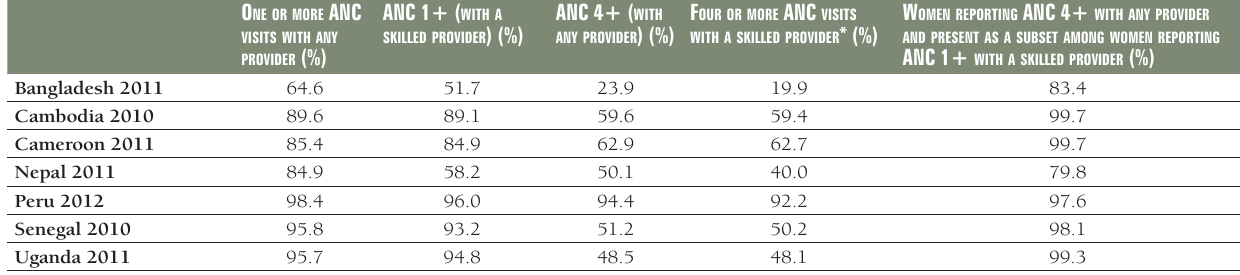
Table 1. Percentage of women who had a live birth in the five years preceding the DHS surveys who reported one ANC visit with a skilled provider and four or more visits with any provider or skilled provider for their most recent live birth, in seven Countdown countries O ne Or mOre AnC AnC 1+ ( with A visits with Any skilled prOvider ) (%) prOvider (%)